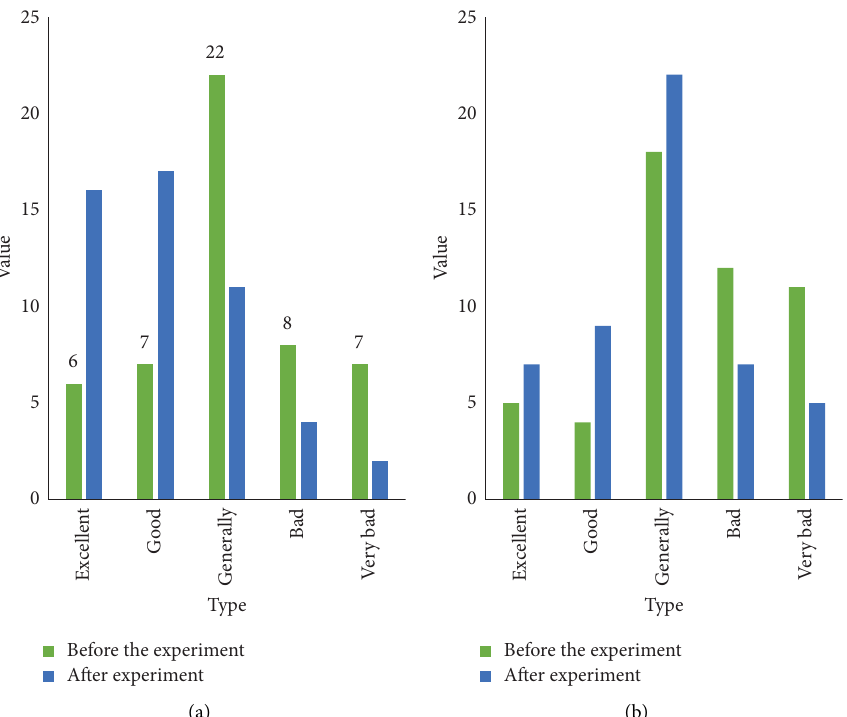
Figure 4: Statistical table of learning attitude survey. (a) Learning attitude of the experimental class. (b) Learning attitude of the control class.